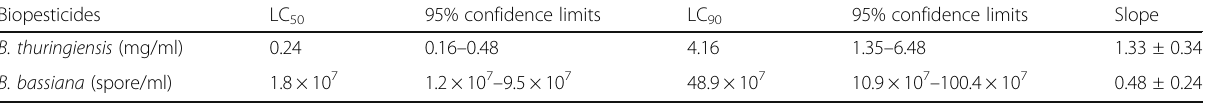
Table 1 Lethal concentrations of B. thuringiensis and B. bassiana against second instar larvae of T. absoluta